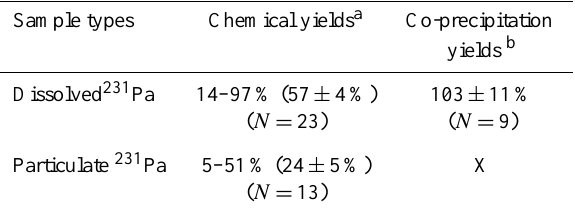
Table 1. Chemical and co-precipitation yields for the KEOPS 231 Pa